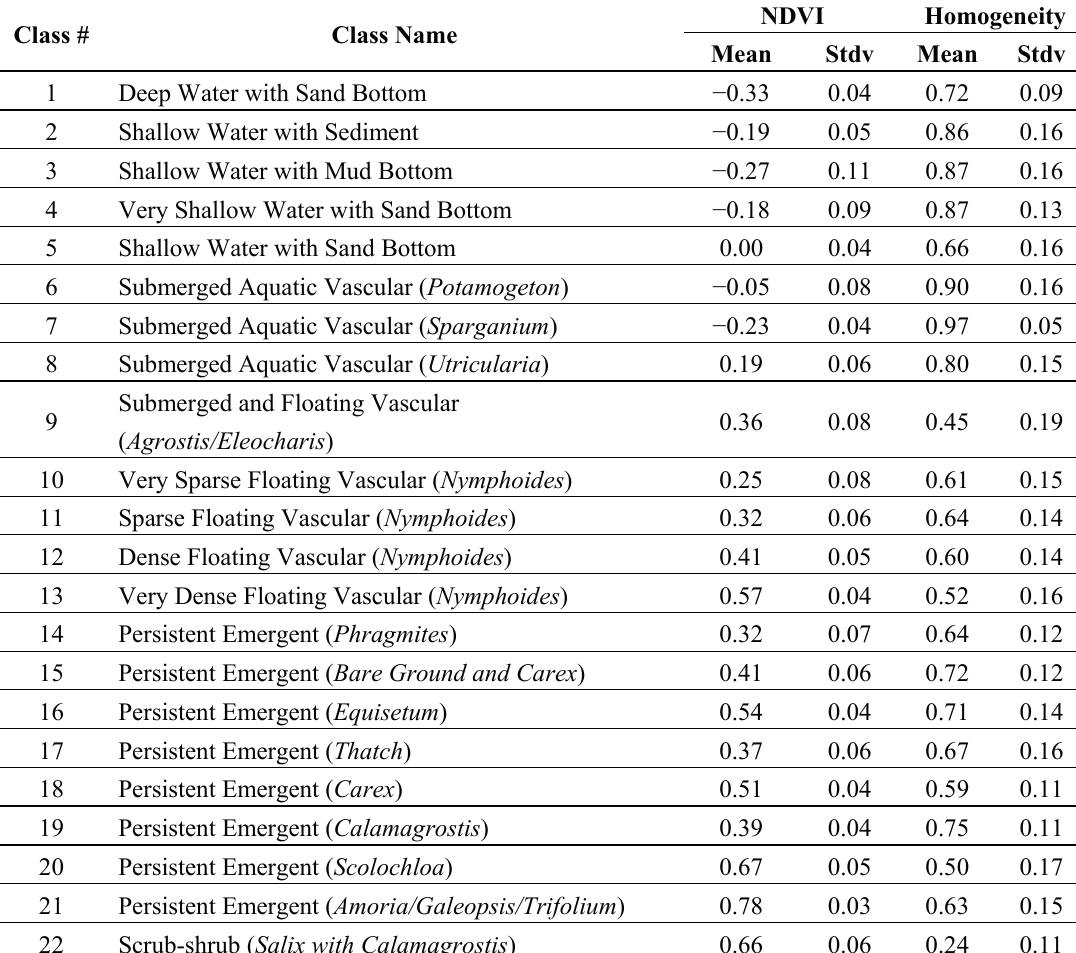
Table 5. Mean and standard deviation (Stdv) of NDVI and textural homogeneity using the Level 5 classification. NDVI values < 0.0 represent little to no detectable photosynthetic activity, while higher values suggest increased green biomass and synthetic activity. Lower homogeneity values ( i.e. , 0.0–1.0) represent areas of greater textural